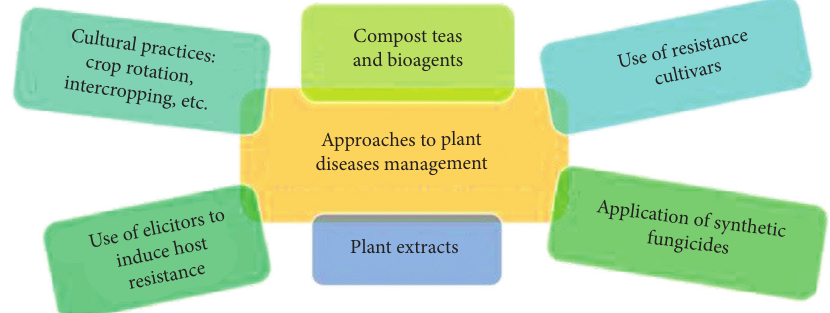
Figure 2: Possible strategies and future perspectives to control the FBG